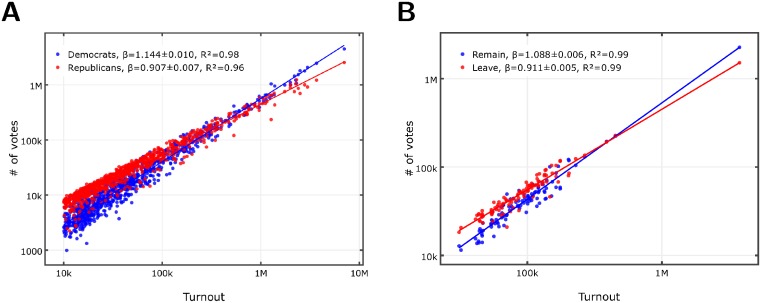
Urban scaling in the presidential elections in the US and in the EU referendum in the UK.Best OLS fit line slopes β and regression coefficients R2 are in the insets (see Section B in S1 File for method details). A Doubly logarithmic plot of votes cast for Republicans (red) and Democrats (blue) as the function of the voter turnout for the 912 largest Metropolitan and Micropolitan Statistical Areas of the US in 2016. B Doubly logarithmic plot of votes cast for Leave (red) and Remain (blue) as the function of the voter turnout for UK urban electoral districts (see Section B in S1 File for method details).